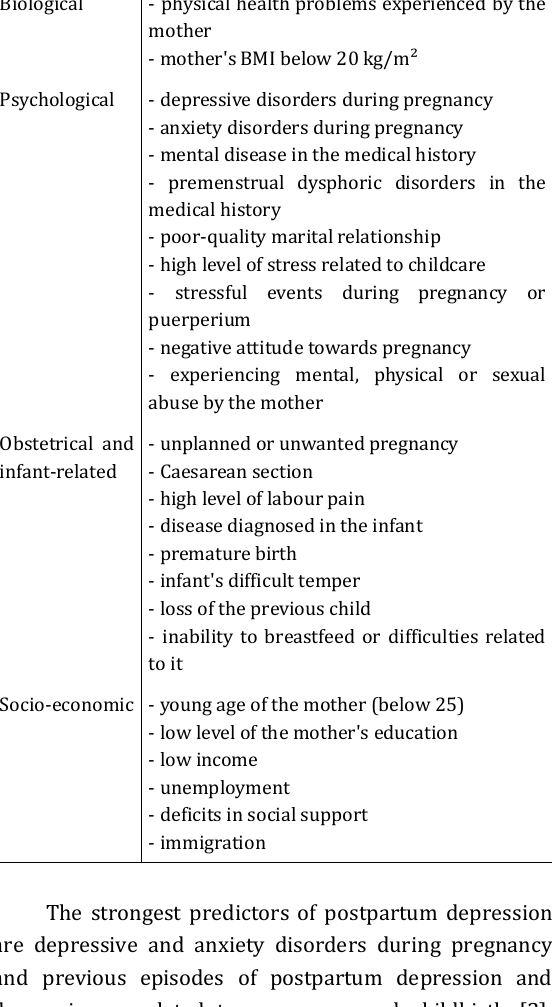
Table 1. Risk factors of postpartum depression